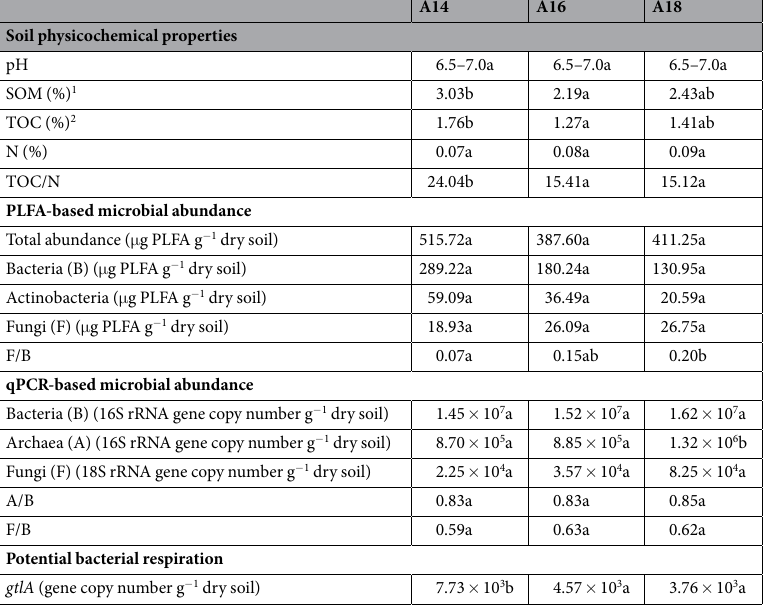
layer A14); Tween 40, L-asparagine, D-mannitol and itaconic acid (preferably consumed in the intermediate layer A16); as well as Tween 80, L-arginine and putrescine (highest oxidation rates in the lower layer A18) (Fig. 1, Table S2). SIMPER pairwise comparisons demonstrated that dissimilarity between soil samples of the interme- diate and lower layers (37.5%) was much lower than that between soil samples of the upper and the intermediate (74.1%) or lower layer (75.7%). This was evidenced in PCA (principal component analysis) since soil samples of the intermediate layer A16 and the lower layer A18 clustered together over PC 1 (Fig. 1).